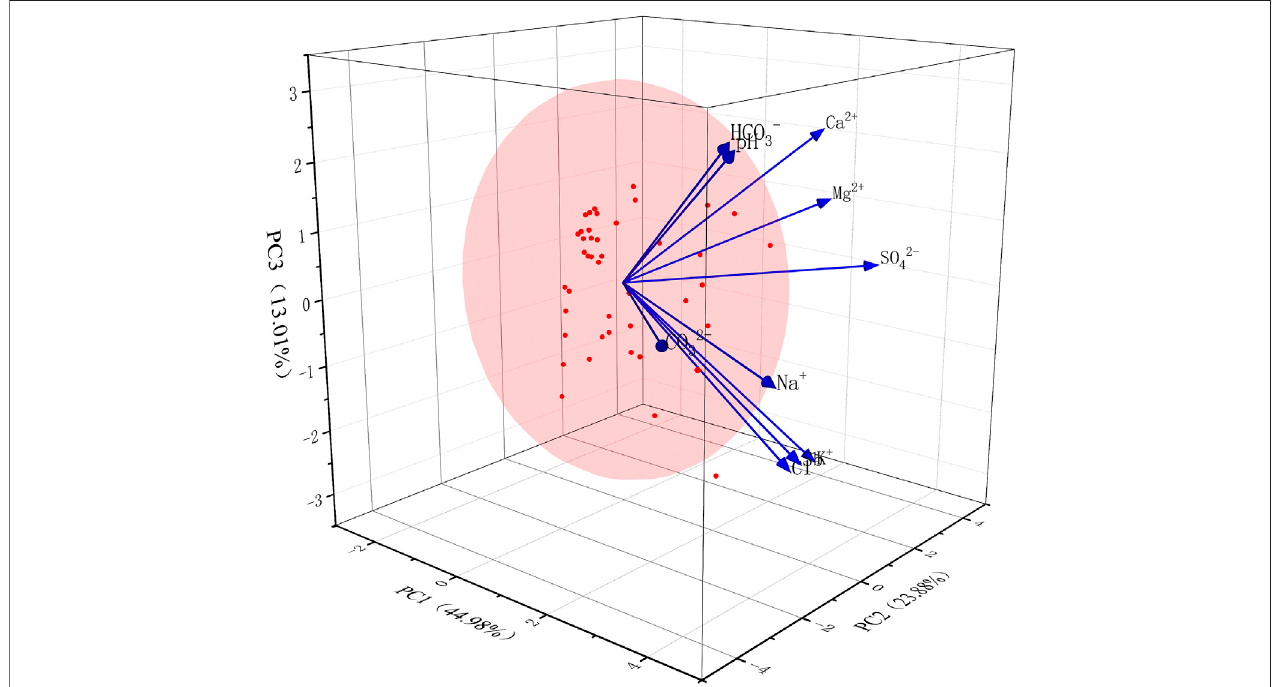
FIGURE 9 | Composition diagram for the groundwater from D 3 x 4